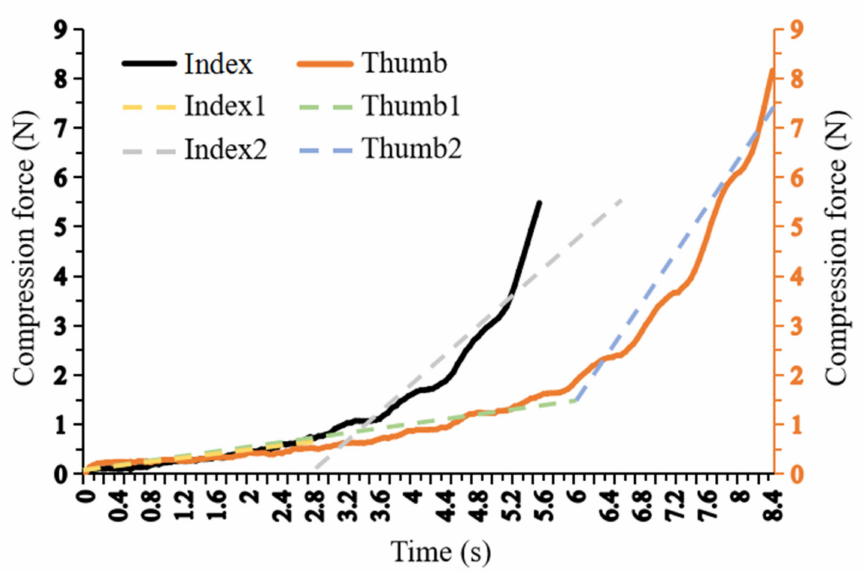
Figure 7. Forces on the engagement